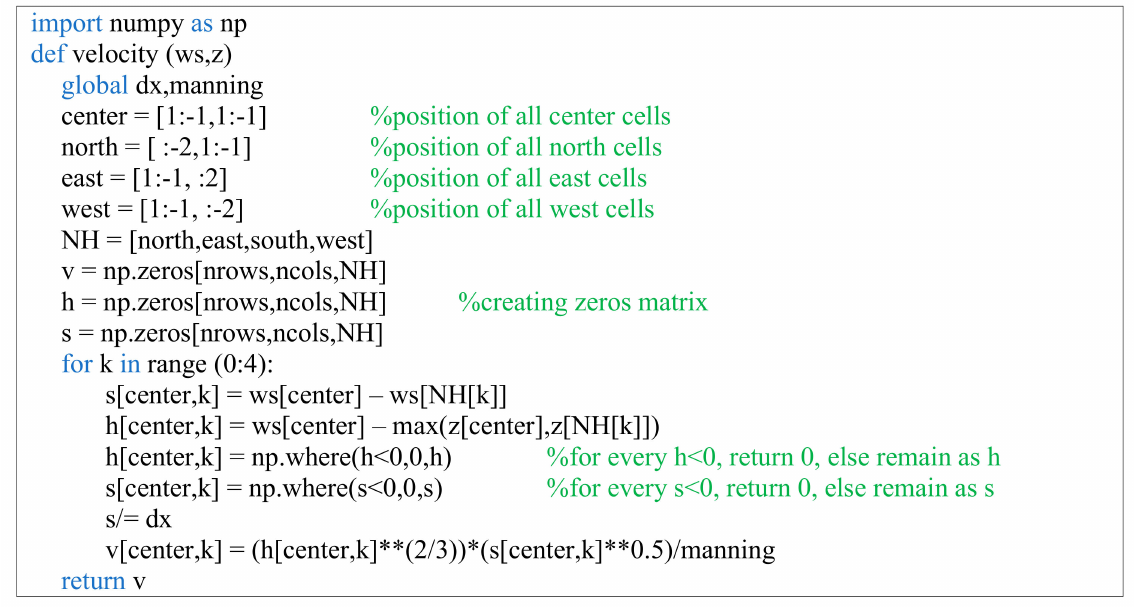
Figure 2. Pseudocode for calculating velocity by using the Numpy function library. Python functions are shown in blue, and comments are shown in